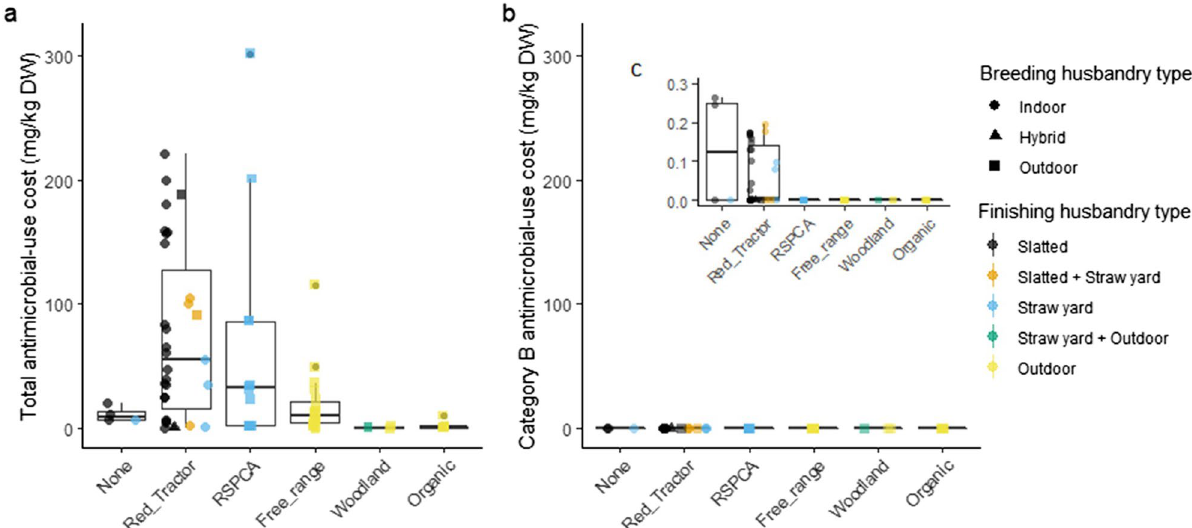
Figure 2. ( a ) total AMU costs and ( b ) category b AMU costs of breed-to-finish pig systems by label type and ( c ) an inset with adjusted y-axis scale. The shapes and colours of scattered points show the type of breeding and finishing subsystems respectively. The upper and lower hinges correspond to the first and third quartiles. Upper and lower whiskers extend to 1.5 times the interquartile range from upper and lower hinges respectively. The middle horizontal bar is the median. The smaller solid black dots refer to outliers which are any points that lie beyond the